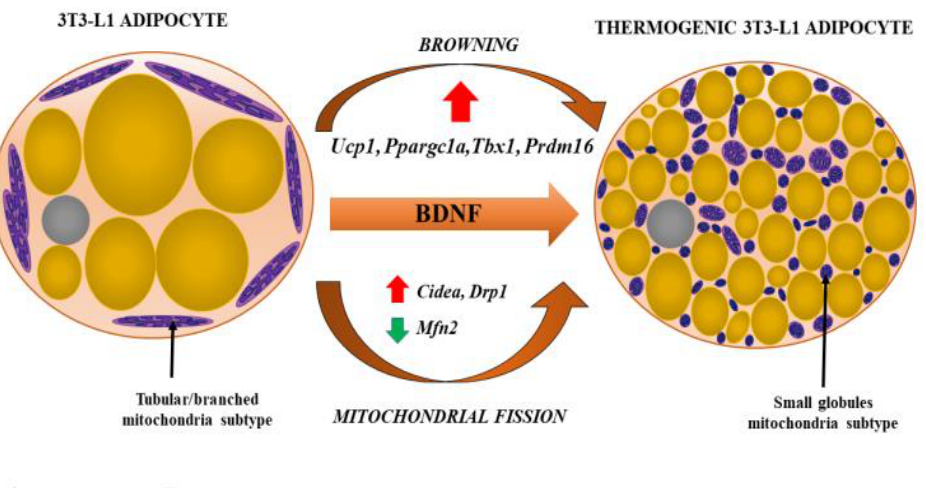
Figure 4. Browning of white adipocyte induced by brain-derived neurotrophic factor (BDNF). The phenotypic change from fat storing to thermogenic adipocytes is recognized by the presence of multilocular lipid droplets and fissed mitochondria that tend to surround lipid droplets, maximizing the efficiency of fatty acid release for thermogenesis. Various genes (their up- and downregulation) involved in the process of browning and mitochondrial fission are indicated by red and green arrows, respectively. From: [18] (reproduced with permission).